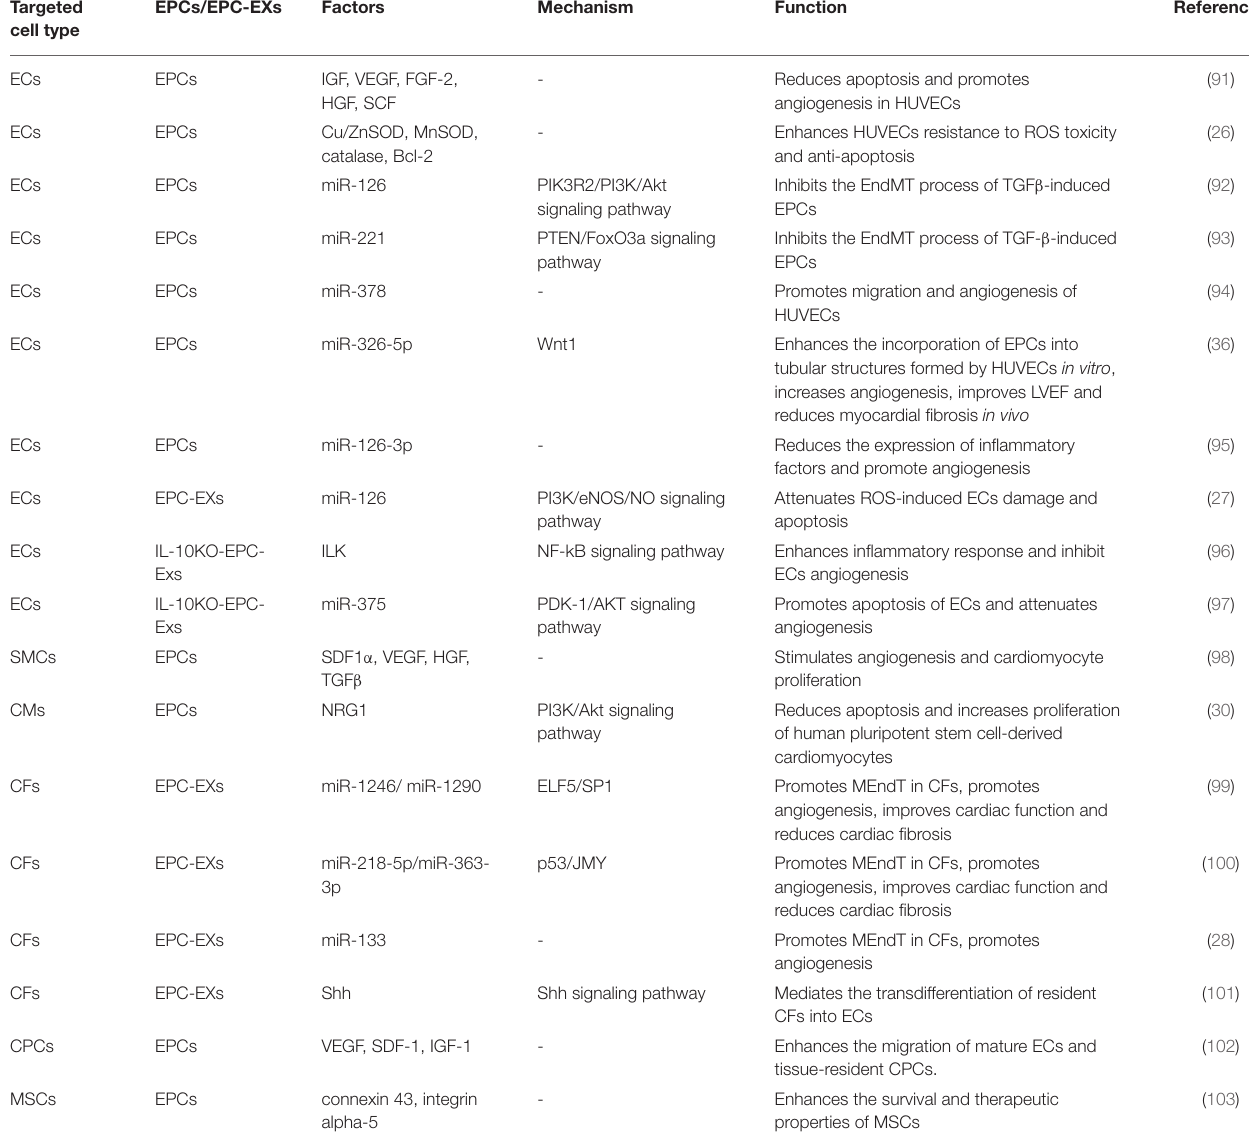
TABLE 2 | EPC interactions with cardiac cell populations and mesenchymal stem cells in ischemic heart disease. Targeted cell